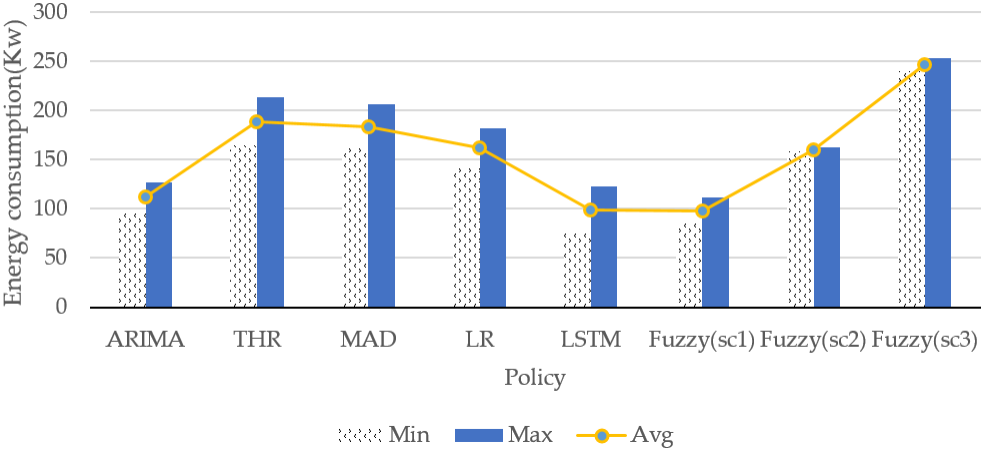
Figure 16. EC according to policy Fuzzy (sc1): Energy, Fuzzy (sc2): Performance, Fuzzy (sc3): Cost.